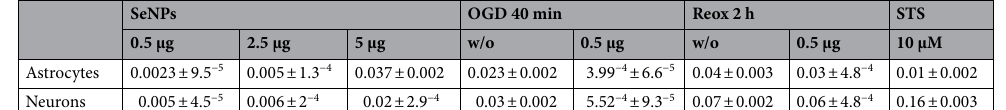
Table 2. The rate of increase in fluorescence of NucView-488 caspase-3 substrate (± SE), reflecting the induction of apoptosis. For each group, 12 samples from 5 cell cultures with cells were